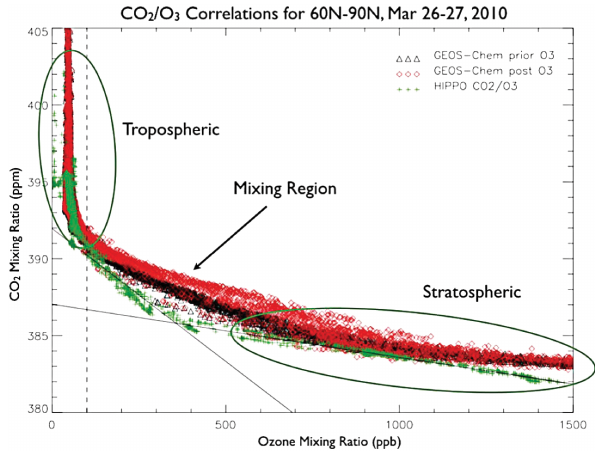
Figure 3. CO 2 /O 3 correlations from GEOS-Chem (red) and HIPPO-3 (green) for 26–27 March 2010, poleward of 60 ◦ N. The high O 3 and low CO 2 values are characteristic of stratospheric air, whereas the low O 3 and high CO 2 values indicate tropospheric air. The values in the UTLS represent a mixture of stratospheric and tropospheric air. The red diamonds represent the GEOS-Chem CO 2 /O 3 correlations obtained after assimilation of the OSIRIS O 3 data in the stratosphere. The two thin black lines show the fit to the HIPPO data in the stratospheric branch and in the mixing region. The vertical dashed line indicates the 100ppb threshold for O 3 , be- low which the air is considered tropospheric in origin.